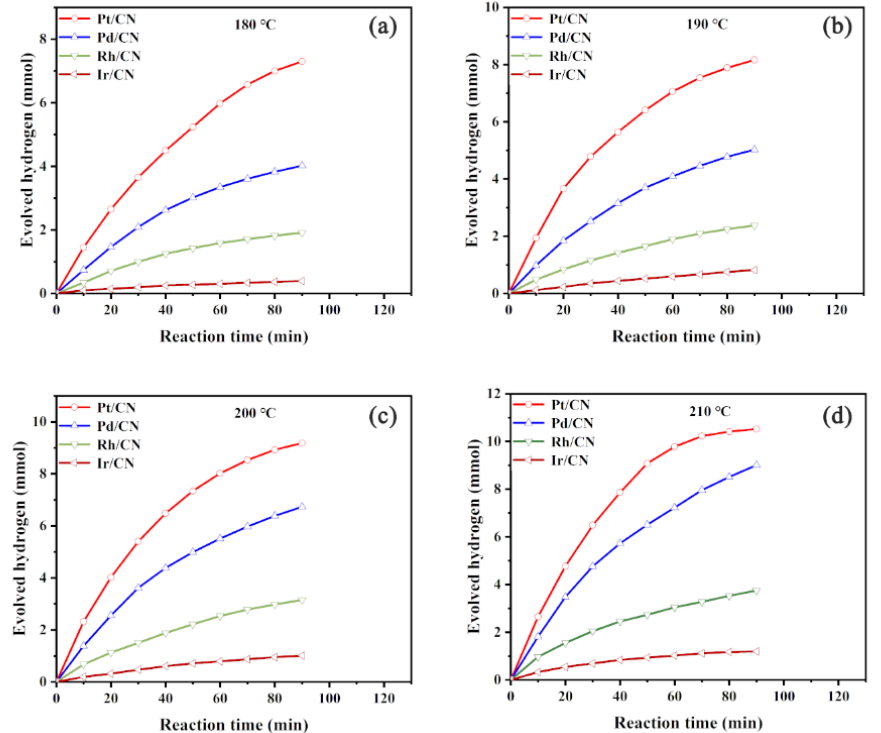
Figure 4. Hydrogen production curves of cyclohexane dehydrogenation with M/CN (M = Pt, Pd, Rh and Ir) catalysts at ( a ) 180 °C, ( b ) 190 °C, ( c ) 200 °C and ( d ) 210 °C.